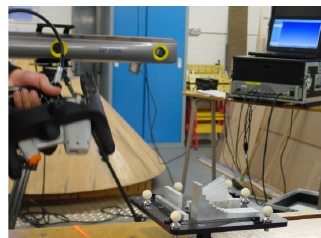
Figure 10. Mock-up for test scan before surface treatment: Angle artefact in two blocks, step artefact in two blocks. Length bars, gap artefact. Bottom left: gauge and does not belong to array.